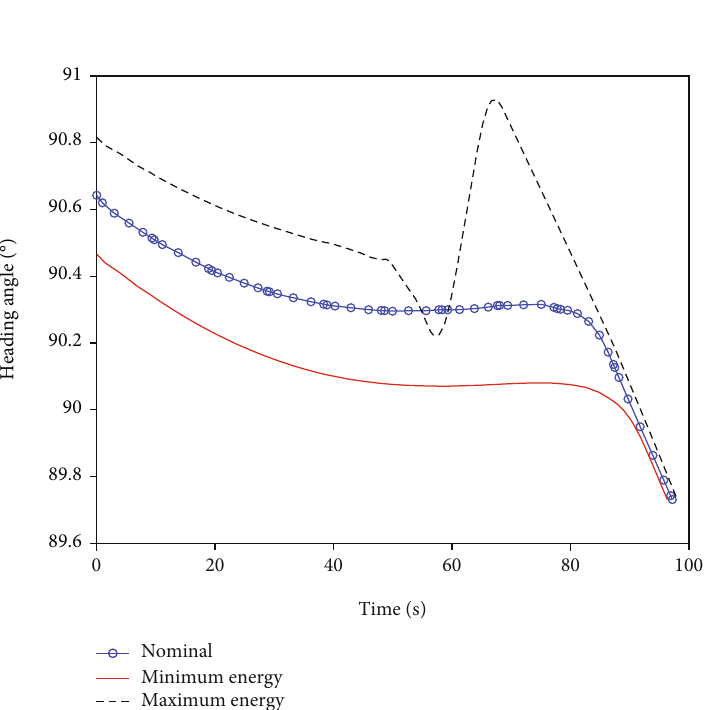
Figure 25: Heading